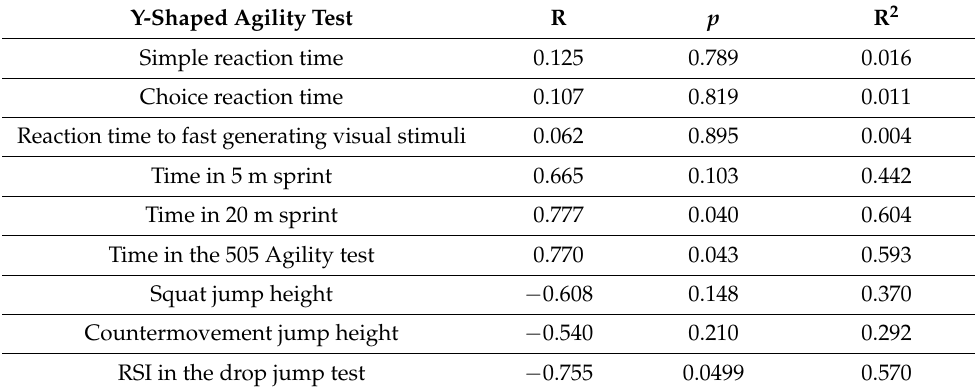
Table 2. Relationship between Y-shaped agility test performance and the sprint speed and strength parameters.